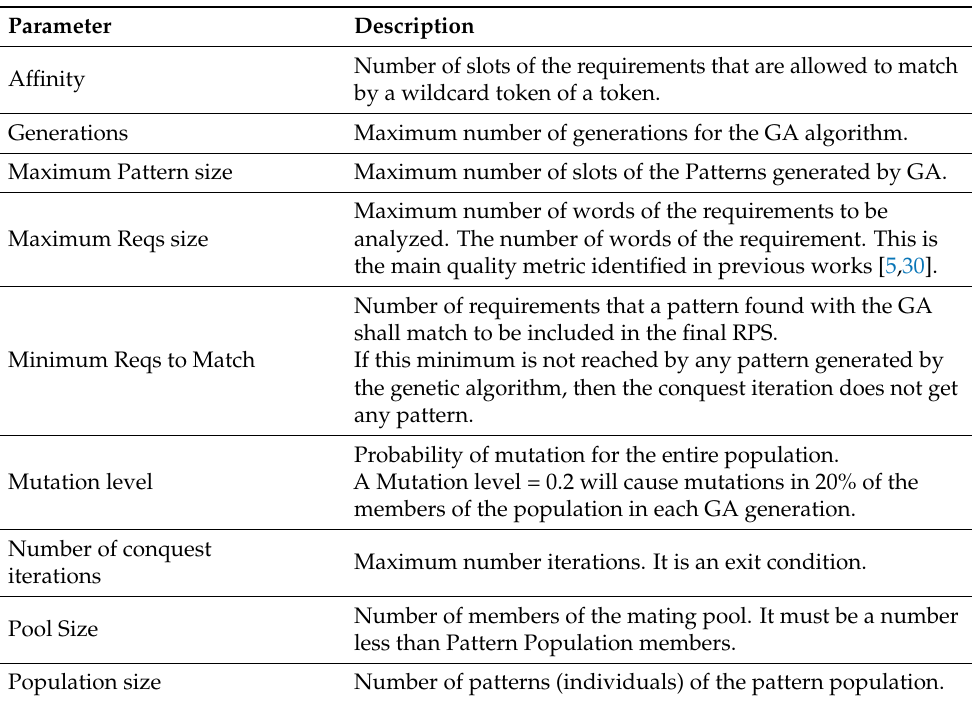
Table 3. Main GA parameters.